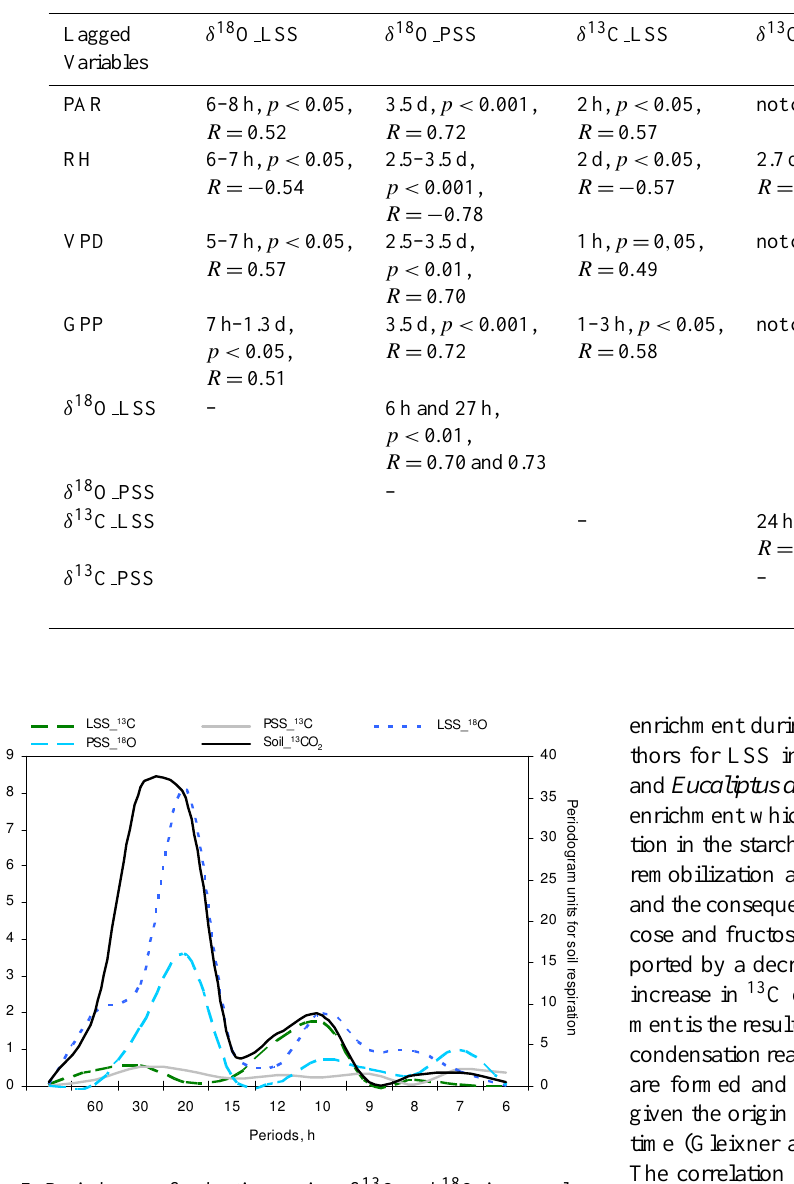
Fig. 5. Periodogram for the time series of 13 C and 18 O in recently fixed sugars in leaf and phloem, and in 13 C of soil respiration. Pe- riods on the x-axes correspond to the number of hours necessary to complete one circle. Periodogram units on the y-axes are dimen-